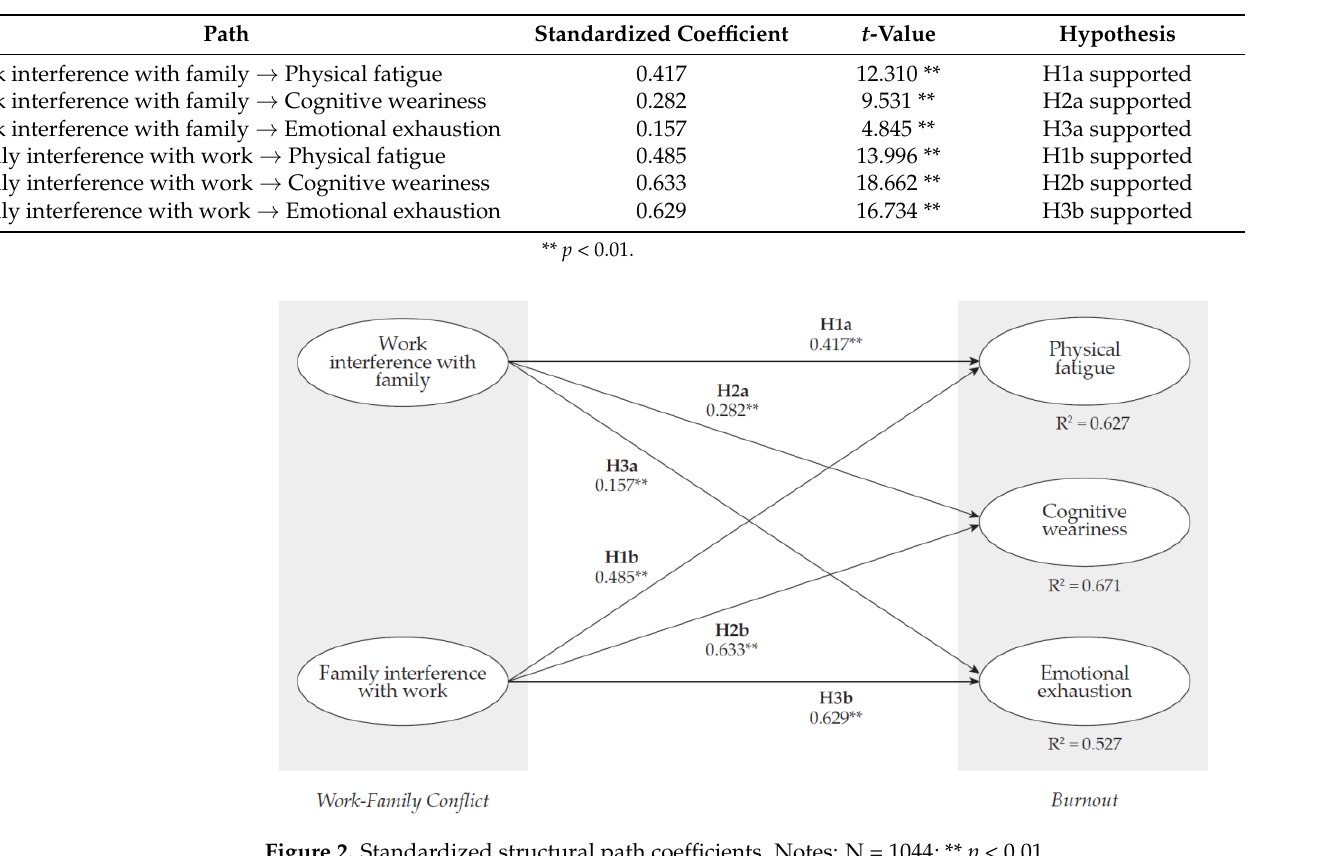
Table 5. Standardized path coefficients for the structural model (overall sample).